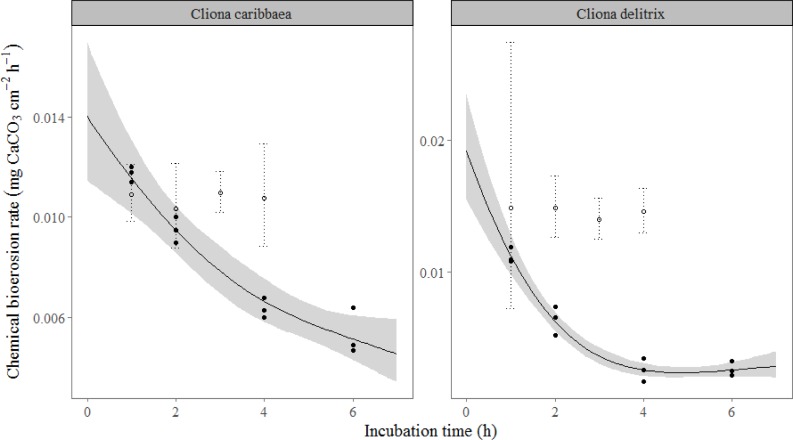
Modelled effect of incubation time on sponge chemical bioerosion rates.Black regression lines represent the modelled (GAM) mean dissolution in mg cm-2 h-1 by Cliona caribbaea (left panel) and Cliona delitrix (right panel) in standing incubations. 95% confidence limits are indicated by the grey band. Solid dots show the calculated mean dissolution rates at T1, T2, T4 and T6 (ST). Open dots represent rates derived from running flow-through incubations at T1, T2, T3 and T4, dotted lines here indicate 95% confidence limits. All rates are obtained using alkalinity anomaly techniques.